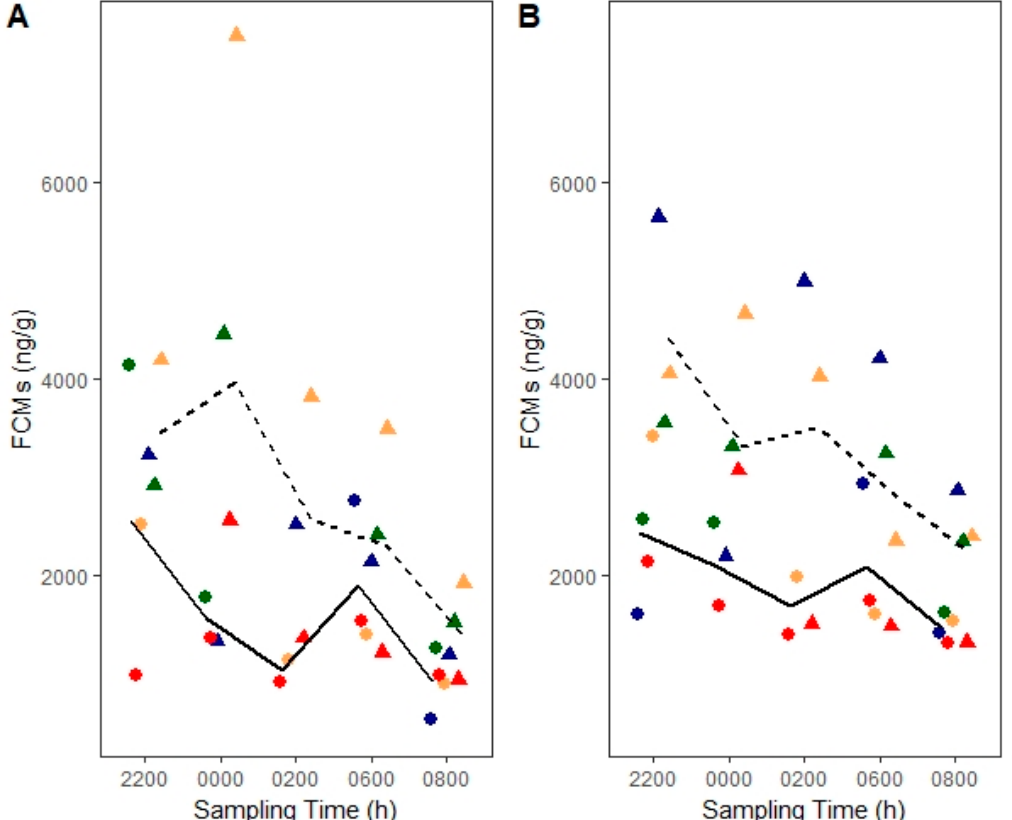
Figure 4. Corticosterone baseline fecal cortisol / corticosterone metabolites (FCMs) (solid lines and circles) versus post adrenocorticotropic hormone (ACTH) FCMs (dashed lines and triangles) in laboratory-bred deermice measured with ( A ) corticosterone enzyme immunoassay (EIA) and ( B ) group-specific EIA. Lines connect means from each sampling time. Circles and triangles indicate individual data points whereby an individual is denoted with a different color. Males are shown in blue and green colors, whereas females are shown in red and tan. ACTH was administered at ~20:00 h (not shown).